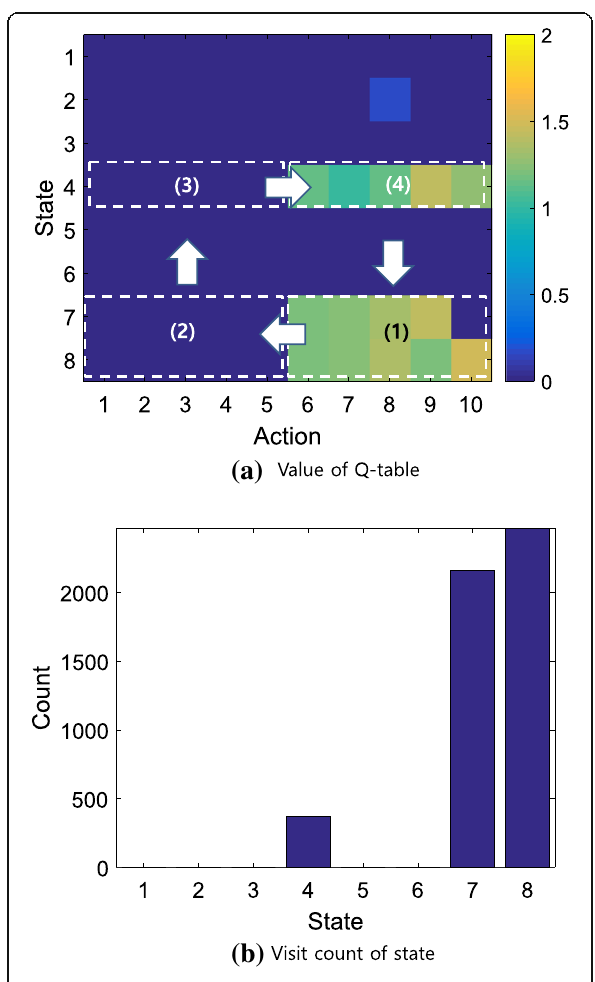
Fig. 15 The a Q-value of Q-table when DDR=3.5 Mbps, and b number of state visits. Similar to Figs. 9 and 10c, the Q-value of Q-table shows the channel movement of high DDR case. The visit count of state is high in the state of high DRE and high CBG because the stable domain is in that